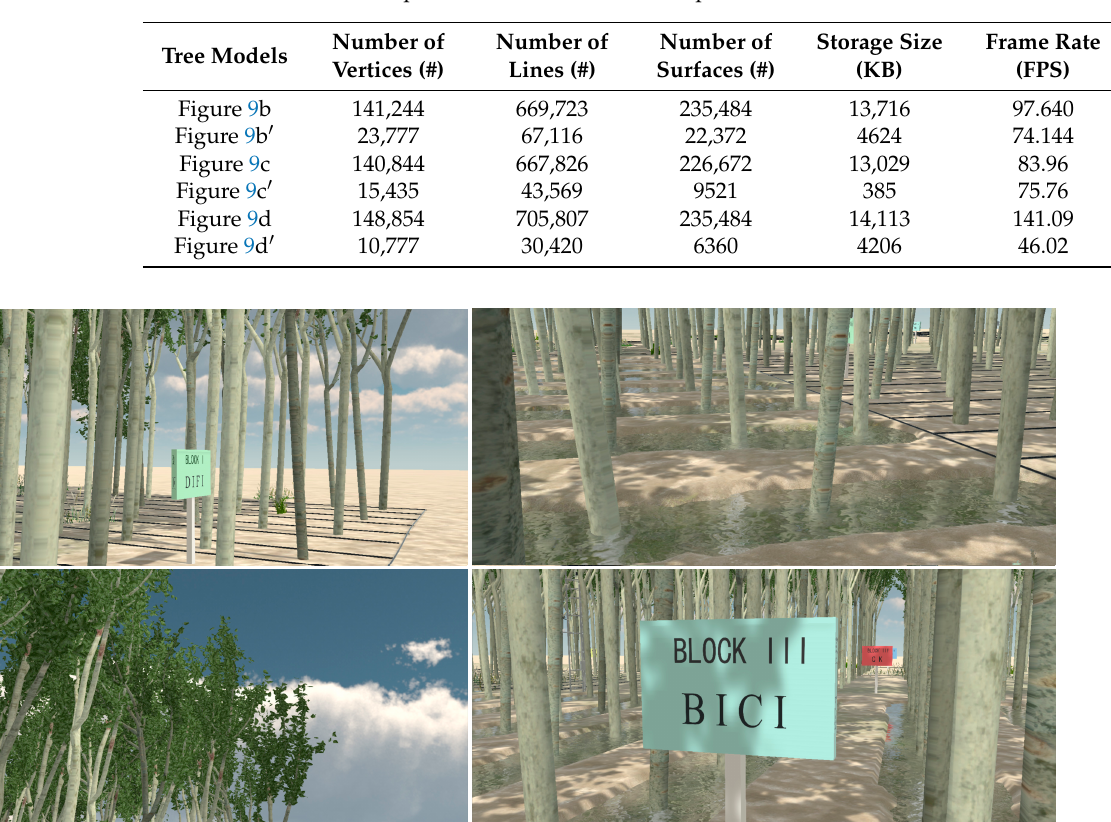
Table 4. Before and after optimization of the number of points, lines and surfaces of the tree model.